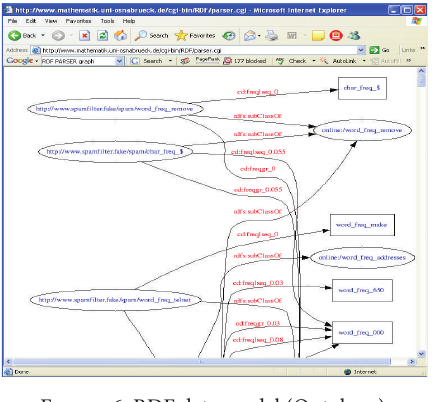
Figure 6: RDF data model (Ontology). Table 1: Classification result of training dataset.